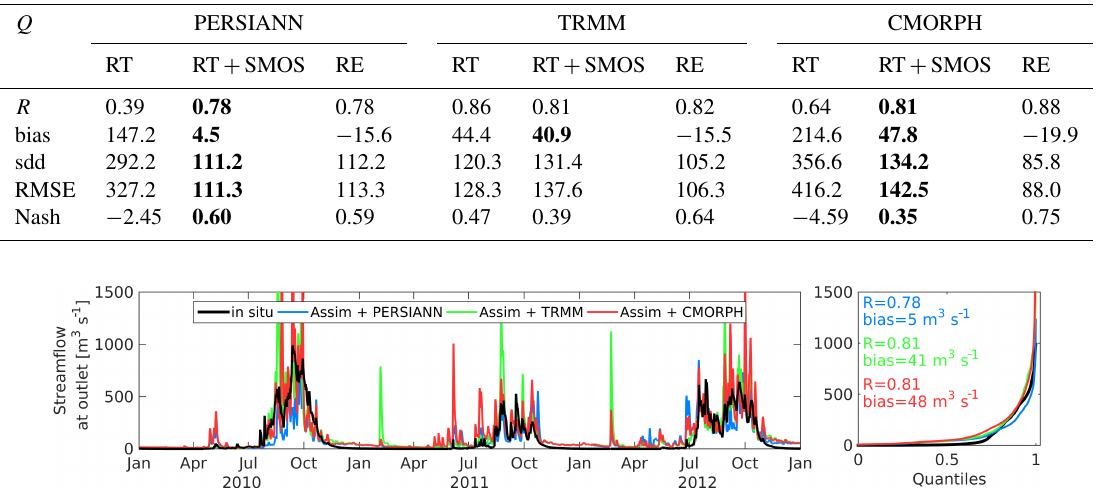
Figure 8. Simulations of the streamflow at the outlet after SMOS soil moisture assimilation with real-time precipitation forcing (indicated in colors for PERSIANN, TRMM and CMORPH) compared to in situ measurements (black line).